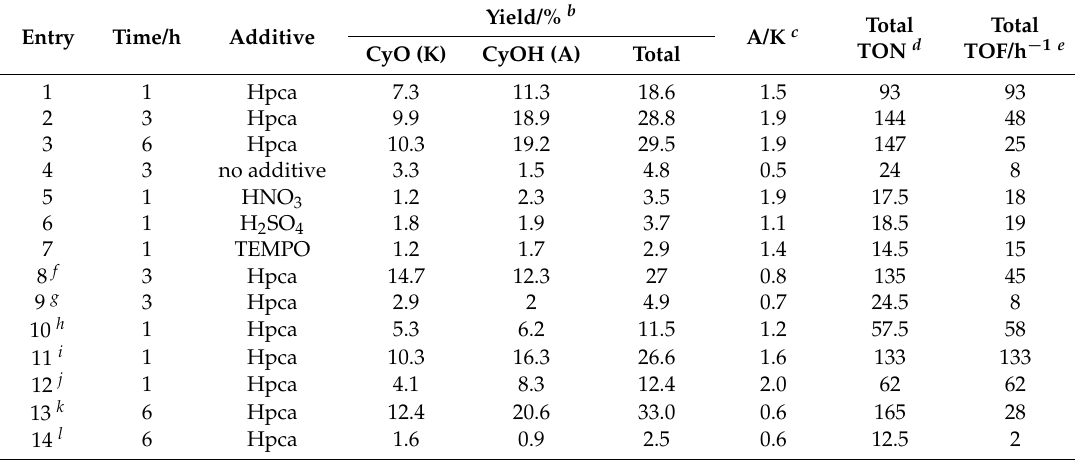
Table 2. Selected data a for the cyclohexane oxidation to KA oil with aqueous TBHP, catalyzed by